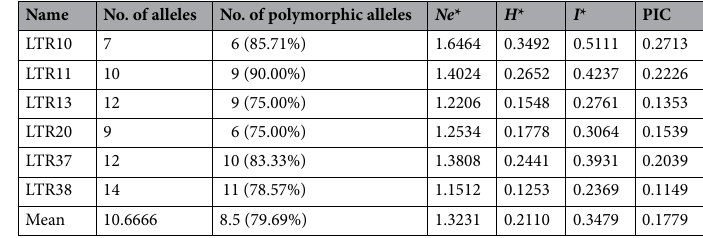
Table 3. Characteristics of the 6 RBIP primer pairs used for constructing sweet potato